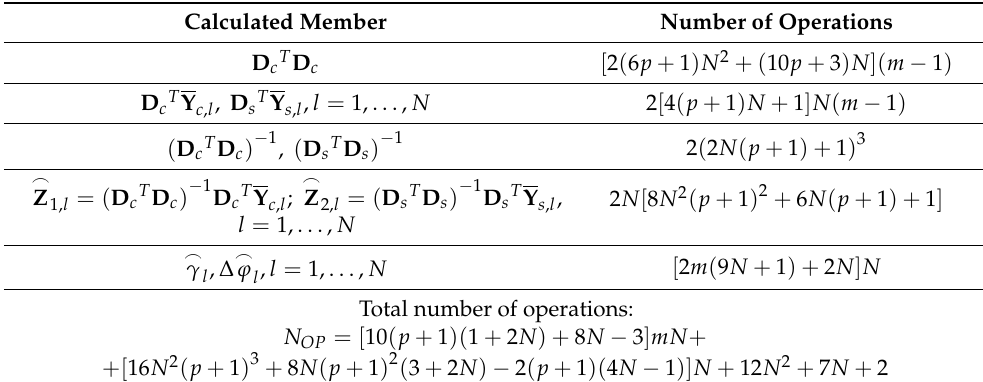
Table 4. Calculation of the computational complexity of the algorithms, described by Equations (5), (8) and (9) for MIMO systems with N transmitting and receiving